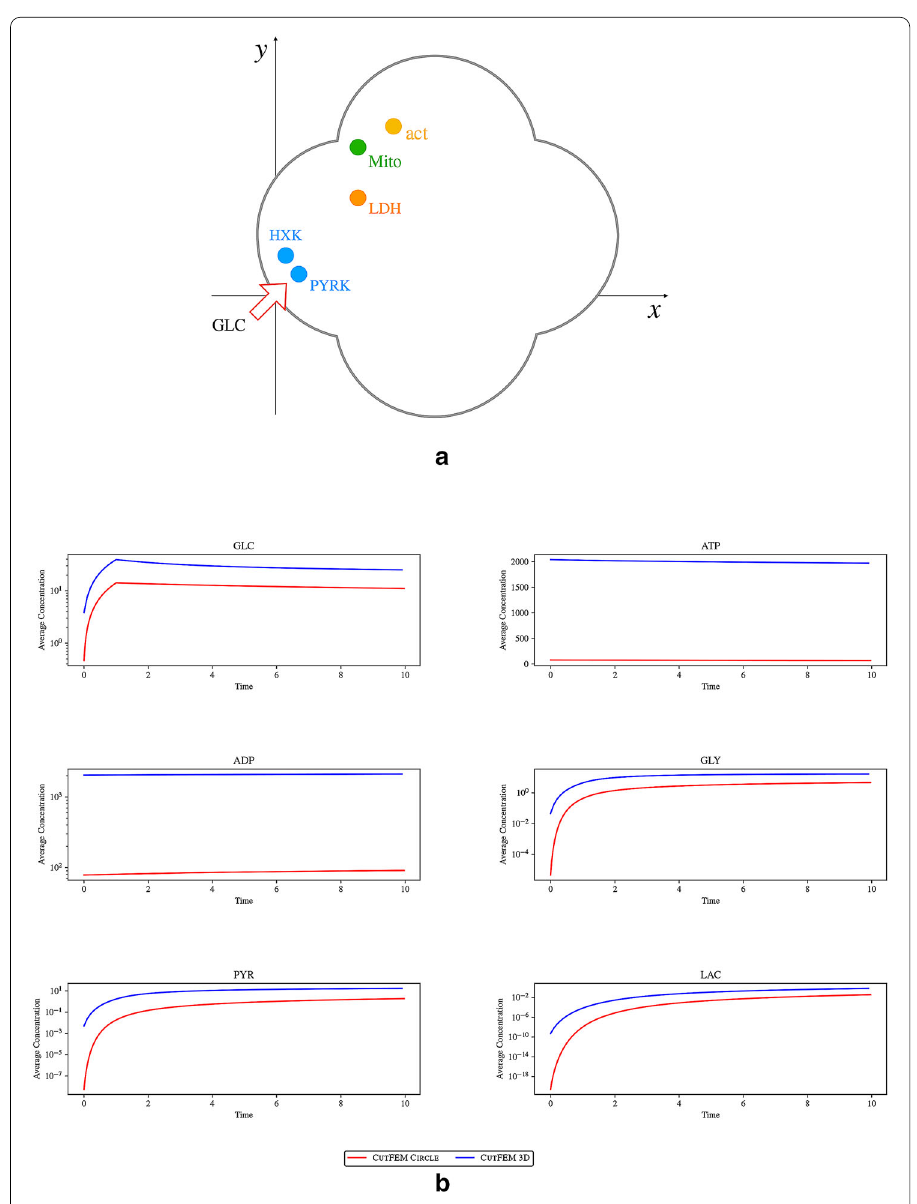
Fig. 12 a Setting of chemical reactions Eqs. (1)–(5) and the source term of GLC for the 3D domain, projected into the x–y axes. b The plot shows the average concentrations of each species computed in the three-dimensional example (blue line) compared with the one obtained in Fig. 6b with CutFEM in the circle